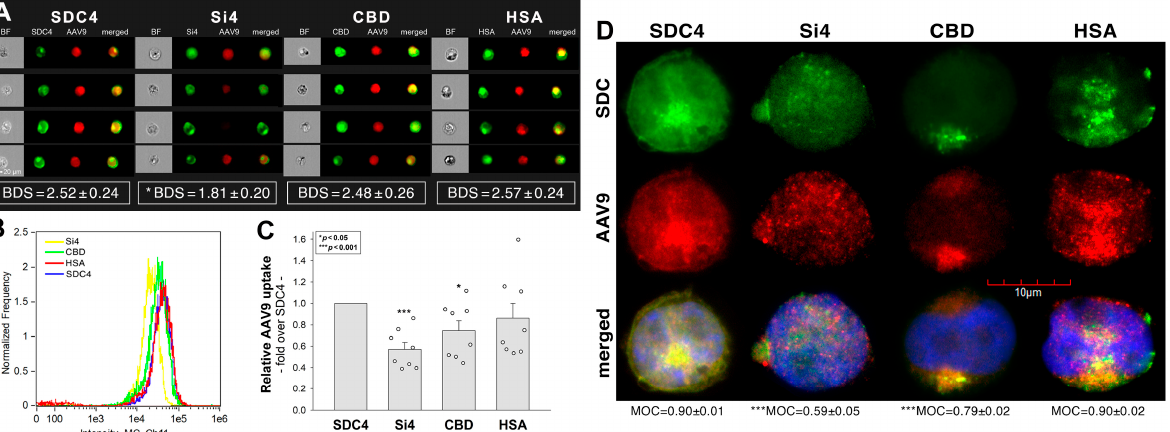
Figure 4. Contribution of the various parts of the SDC4 ectodomain to AAV9 uptake. GFP-tagged SDC4 mutants incubated with AAV9 vectors at 4 × 10 4 vg/cell for 6 h were fixed, permeabilized, and treated with specific primary AAV9 and AF 633-labeled secondary antibodies. The cellular uptake of AAV9 was then analyzed with imaging flow cytometry and confocal microscopy. ( A , B ) Representative fluorescent images and flow cytometry histograms showing the intracellular fluorescence of AAV9-treated SDC4 mutants. Scale bar = 20 μ m. The indicated BDS values of AAV9 and SDCs represent the mean + SEM of eight independent experiments. Statistical significance was assessed with ANOVA. ( C ) Detected fluorescence intensities were normalized to AAV9-treated transfectants expressing GFP-labeled WT SDC4 as standards. The bars represent mean + SEM of eight independ- ent experiments. Statistical significance vs. standards was assessed with ANOVA. * p < 0.05; *** p < 0.001. ( D ) Confocal microscopic visualization of AAV9-treated SDC4 mutants. Scale bar = 10 μ m. MOC ± SEM for the overlap of AAV9 with the mutants was calculated by analysis of 15 images with ~10 cells in each image (from three separate samples). Statistical significance vs. AAV9-treated trans- fectants expressing WT SDC4 (standards) was assessed with ANOVA. *** p < 0.001.